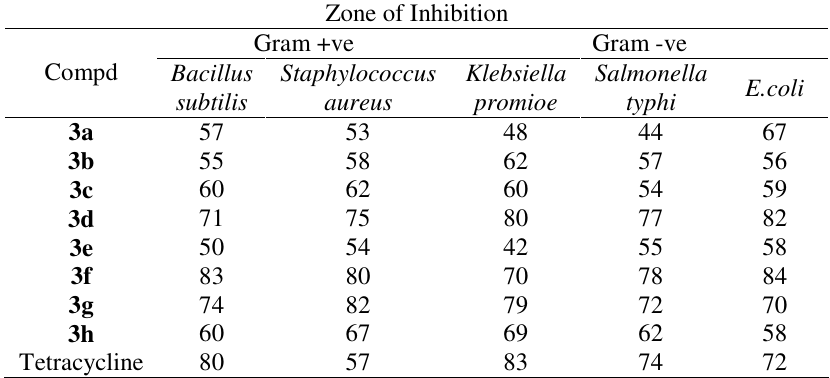
Table 3. Antibacterial activity of compounds ( 3a-h ).